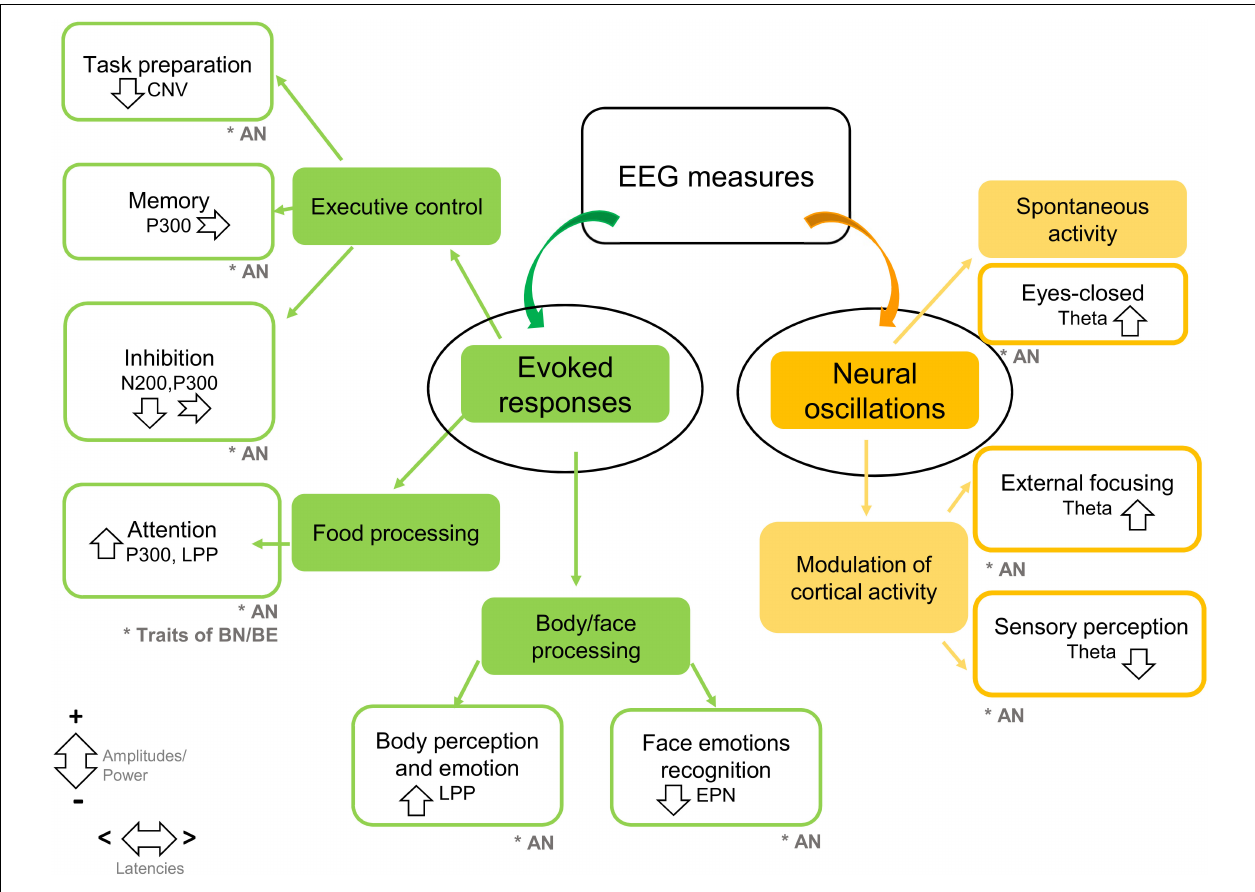
FIGURE 2 | Summary of EEG findings in feeding disturbances in children and adolescents. Studies are grouped by methodologies of EEG analysis (evoked responses, neural oscillations), and experimental protocols. The main EEG markers and findings are summarized. Down-ward arrows indicate decreased amplitudes/power; upward arrows indicate increased amplitudes/power. Horizontal arrows indicate shorter/longer latencies (CNV, contingent negative variation; EPN, early posterior negativity; LPP, late positive potential; AN, anorexia nervosa; BN, bulimia nervosa; BN, binge eating). The symbol * means target